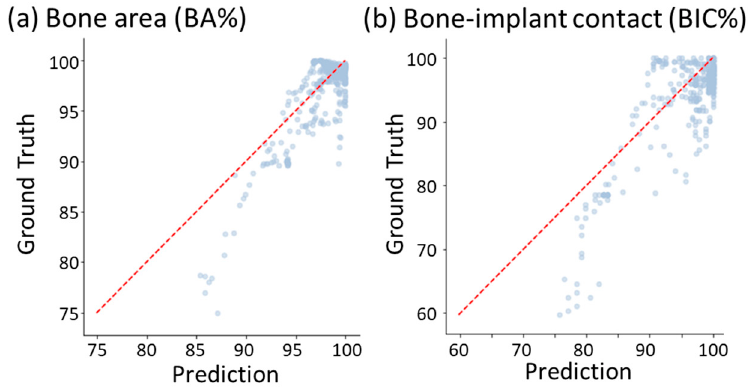
Figure 6. The correlation plot between prediction and the ground truth (FE results) of performance indexes.